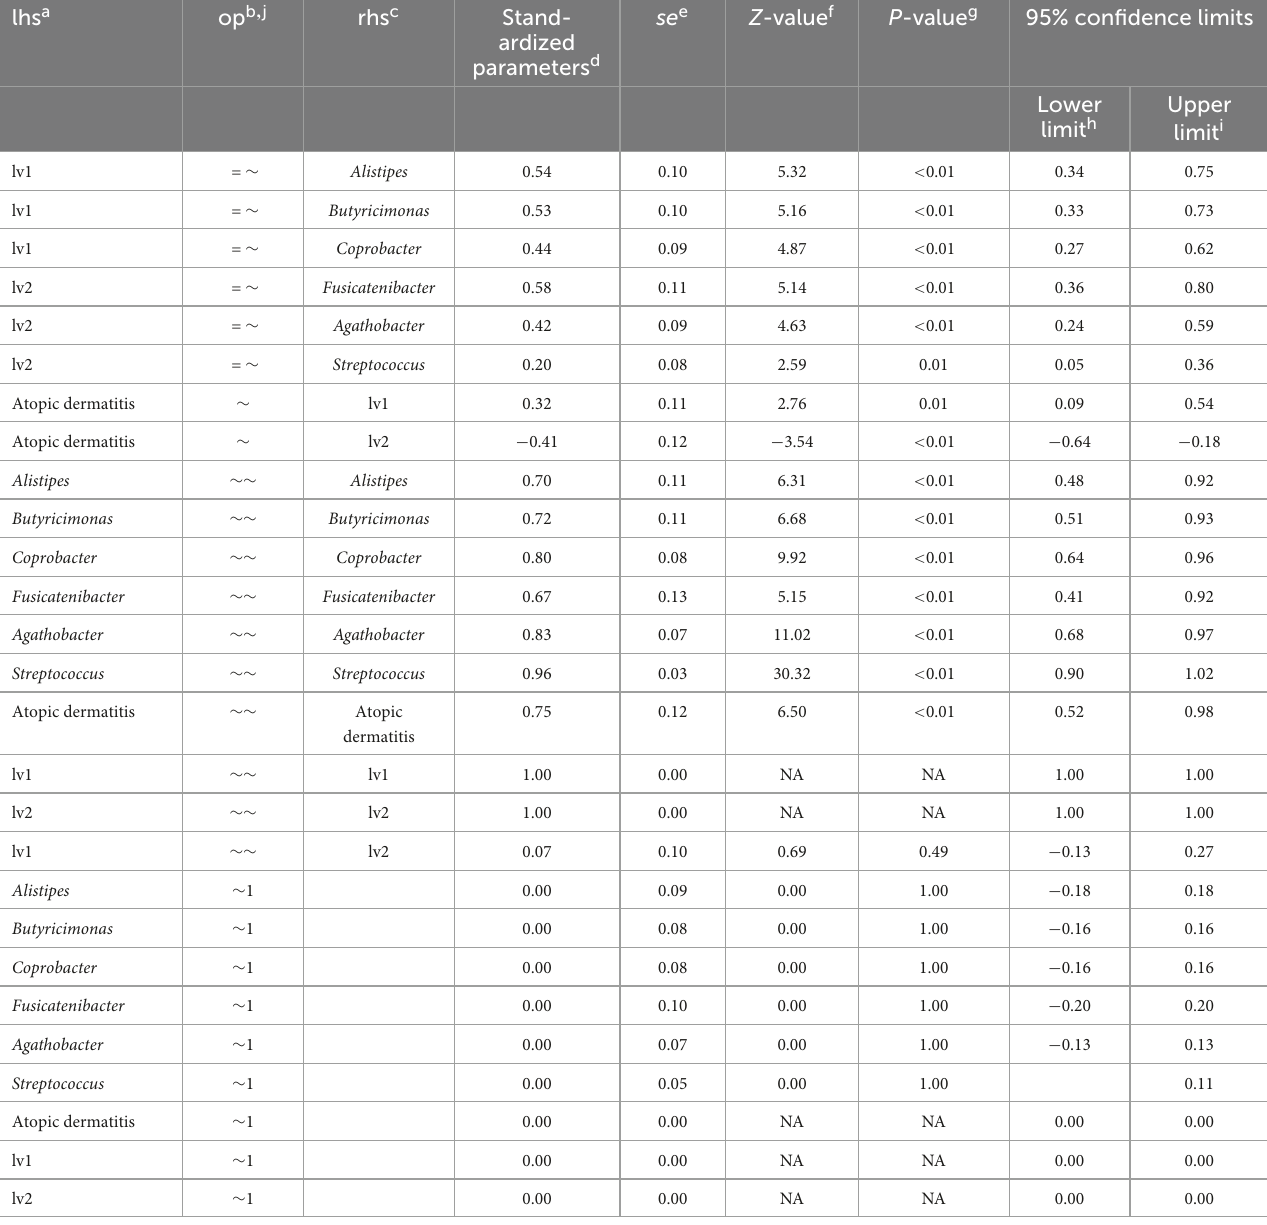
TABLE 3 Results of the structural equation modeling (SEM) for